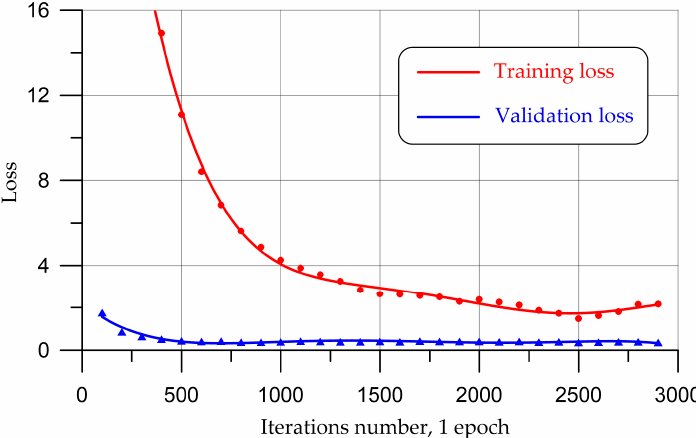
Figure 5. Model training schedule.